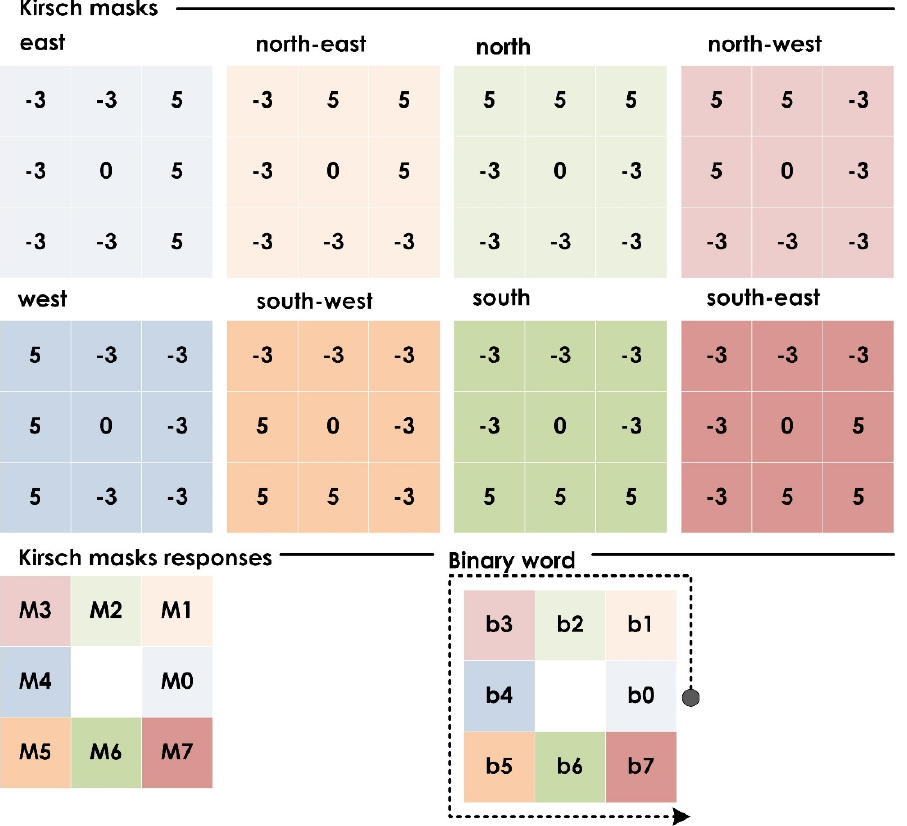
Figure 6. Preprocessed 4-chamber heart images and the corresponding LDP images.